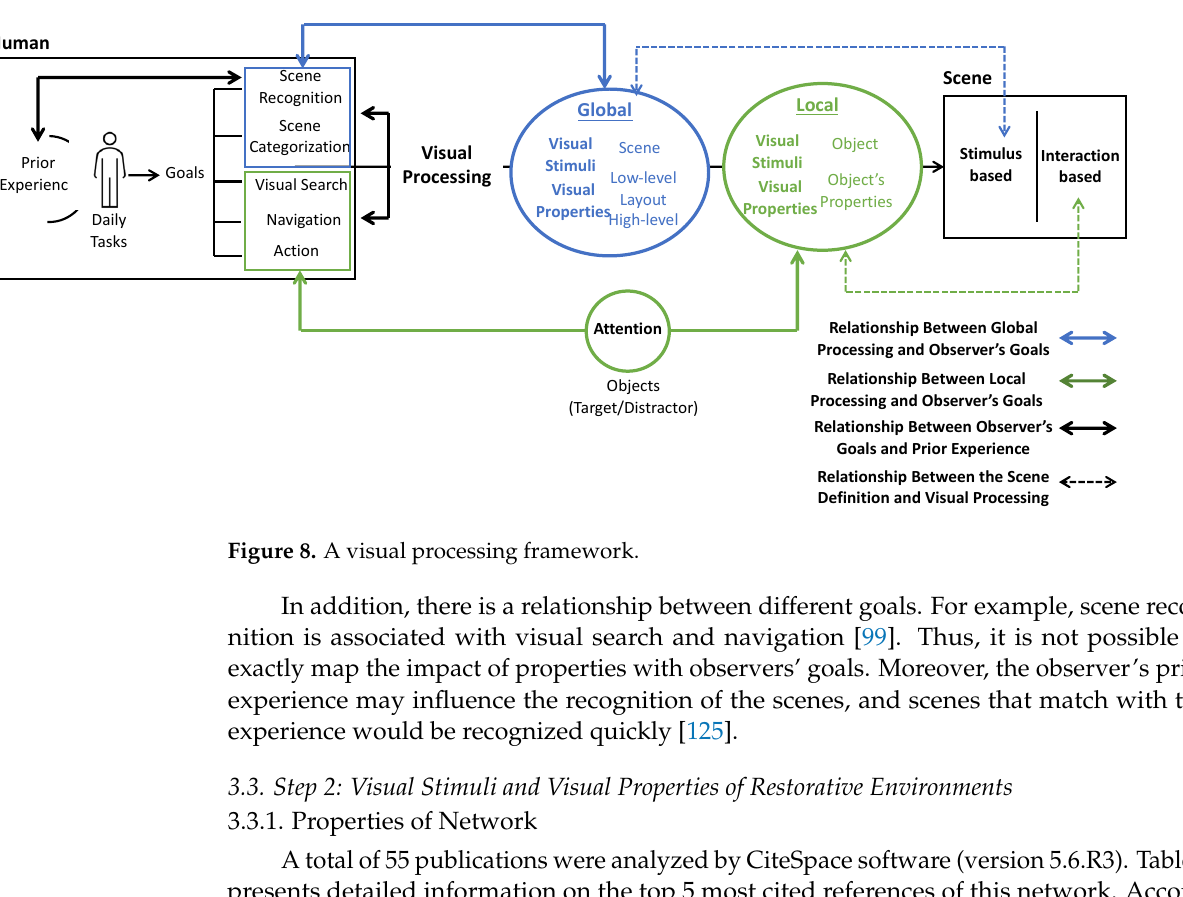
Table 7. Top 5 most cited references of network for the second step of the review, visual stimuli, and visual properties of restorative environments.